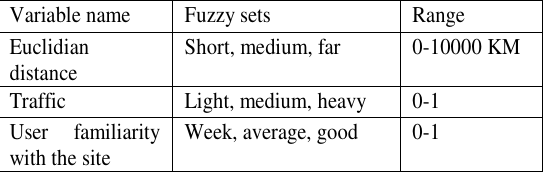
Table 2: NFC features (inputs)